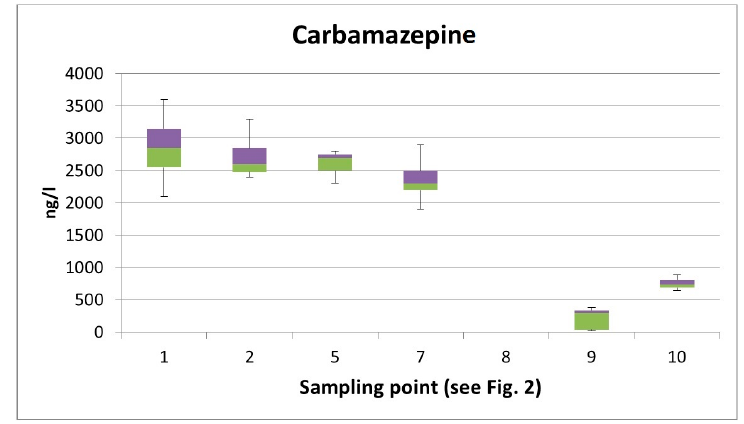
Figure 3. Box plots of carbamazepine concentrations monitored in 2014–2015 in the effluent from the wastewater treatment plant in Horní Be ř kovice downstream to the village of Damin ě ves.